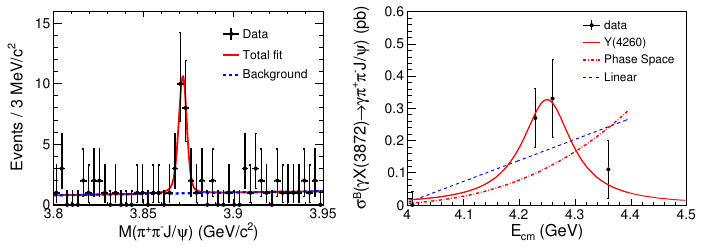
Figure 7. Fit the M ( π + π − J /ψ ) distribution observed at BESIII (left panel), and fit to σ B [ e + e − → γ X (3872)] × B [ X (3872) → π + π − J /ψ ] (right